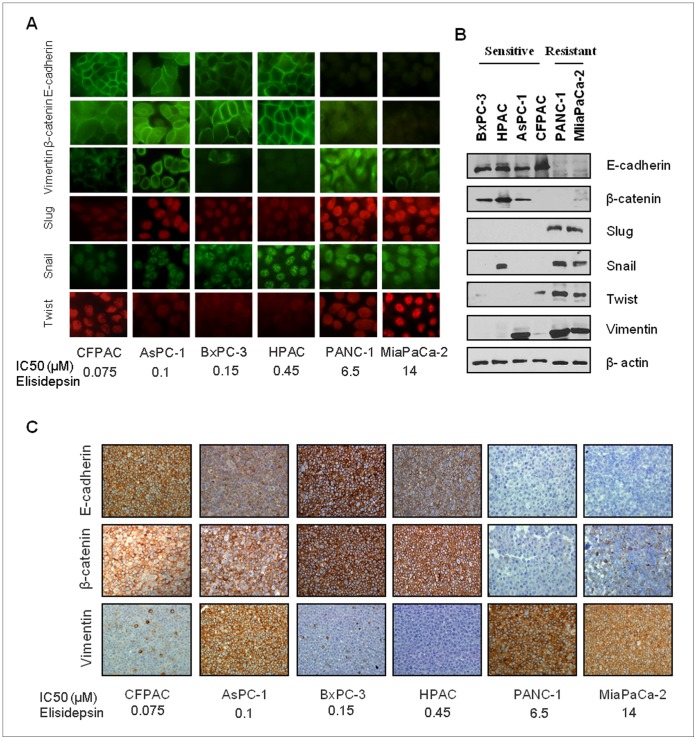
Expression of EMT markers associated with elisidepsin sensitivity in pancreatic cancer cell lines.E-cadherin, β-catenin, vimentin, Slug, Snail and Twist basal expression levels were evaluated by immunocytochemistry (A) and western blot (50 µg of protein/lane) (B). Magnification 100x. Membranes were stripped and reprobed with anti-β-actin as an internal control. C) E-cadherin, β-catenin and vimentin protein expression levels were evaluated by IHC. Magnification 20x. These analyses were performed in duplicate.